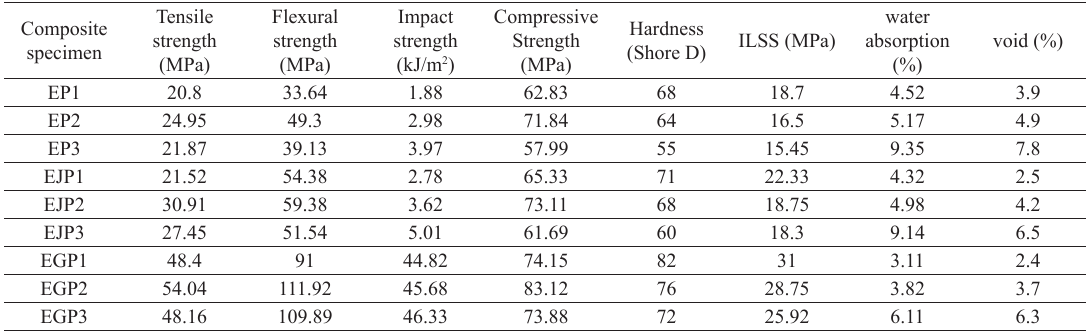
Table 4. Decision matrix.